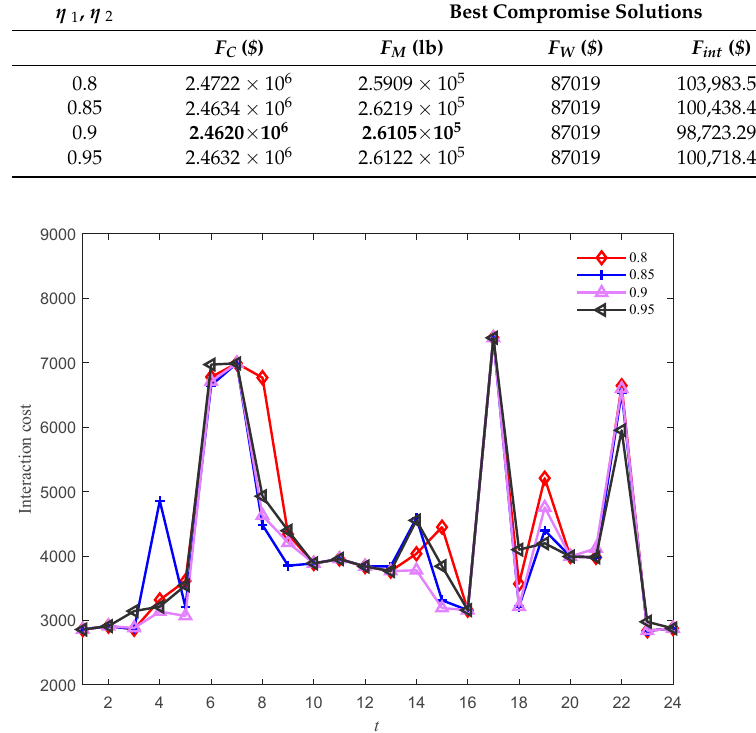
Figure 6. Interaction cost obtained at different confidence levels.